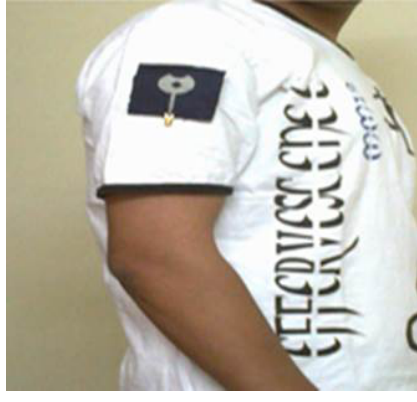
est clothing material available on the market. Conductive fabric is a copper fabric purchased from the market. It is a cloth of conductive threads which makes it robust for use it wherever necessary.